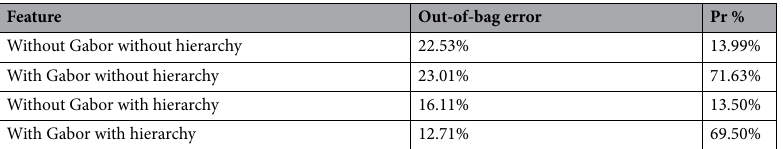
Table 2. Out-of-bag (Sub). Our-of-bag error results from the random forest classifier and percentage of right segmented pixels (PR) in the whole image for the sub-objects.